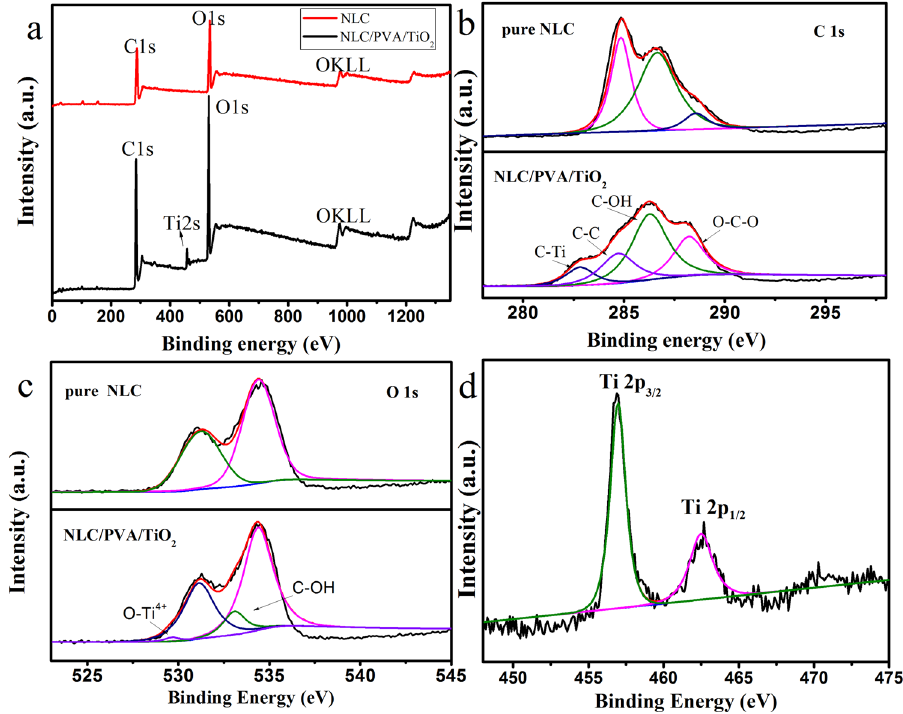
Figure 4. XPS spectra of ( a ) survey spectrum, ( b ) C1s, ( c ) O1s in pure NLC and NLC/PVA/TiO 2 composite, respectively and ( d ) Ti 2p in NLC/PVA/TiO 2 composite.